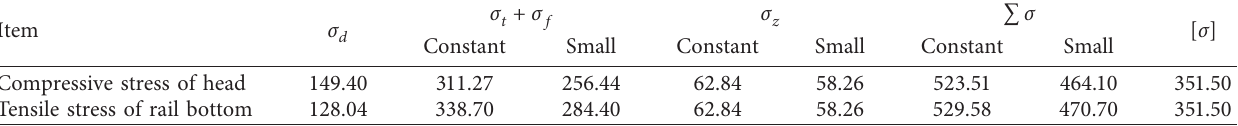
Table 2: Rail strength calculation (unit: